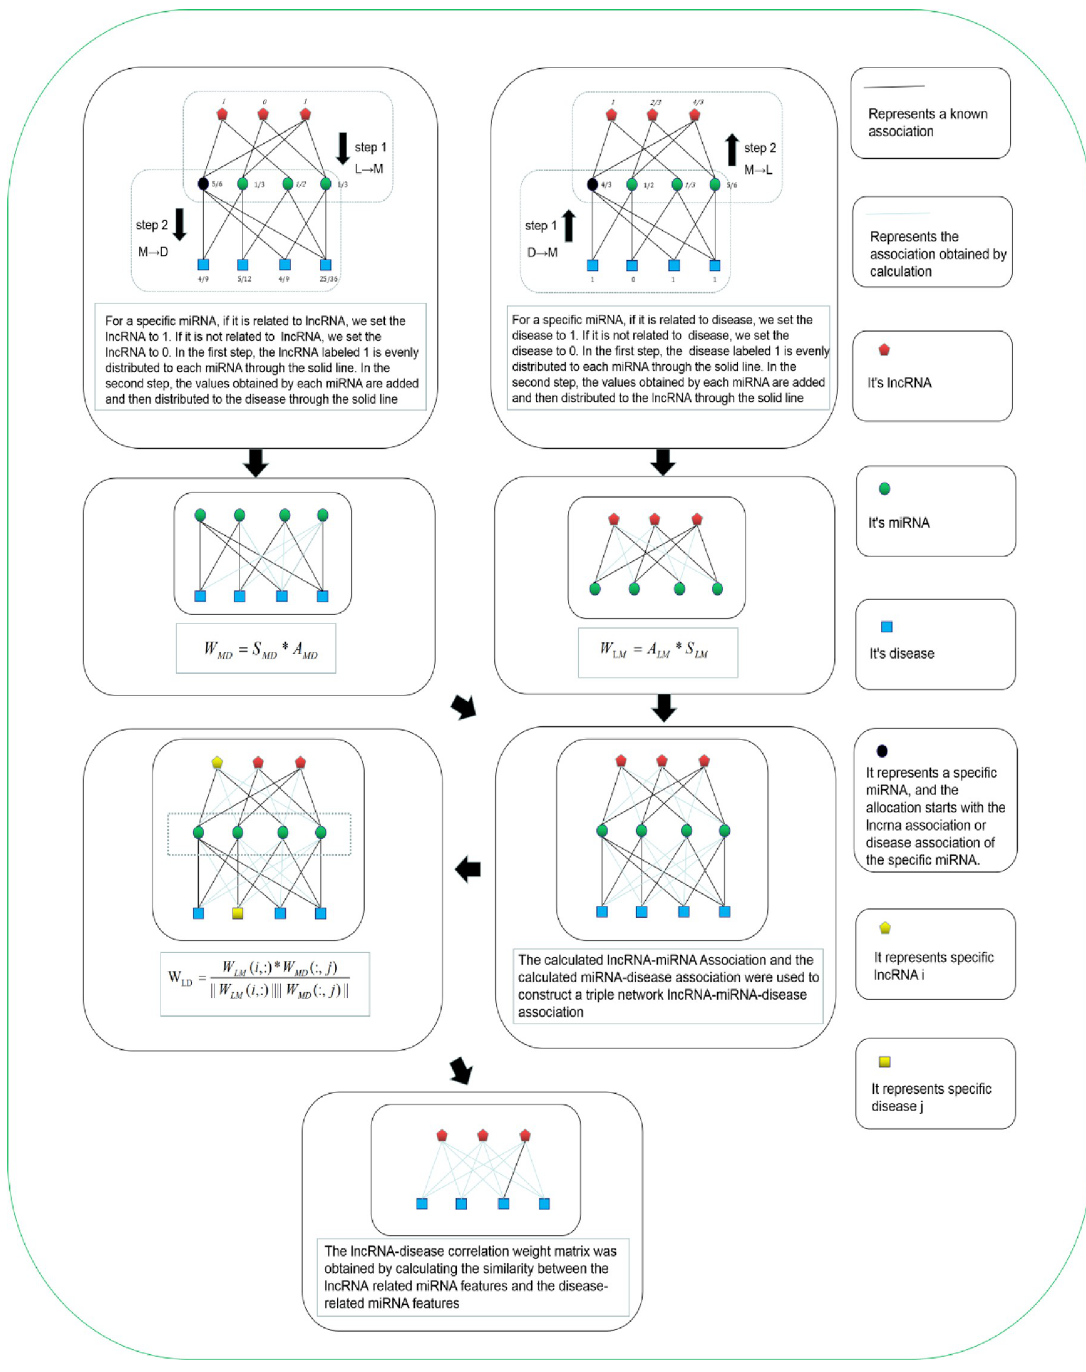
Fig 1. Flow chart of lnRNA-disease association weight matrix construction. and a represents an entity in the lncRNA-miRNA matrix A ij formed by miRNA j corresponding to all lncRNA-miRNA relationships (if lncRNA is associ- ated with miRNA, the value is 1; otherwise, the value is 0).